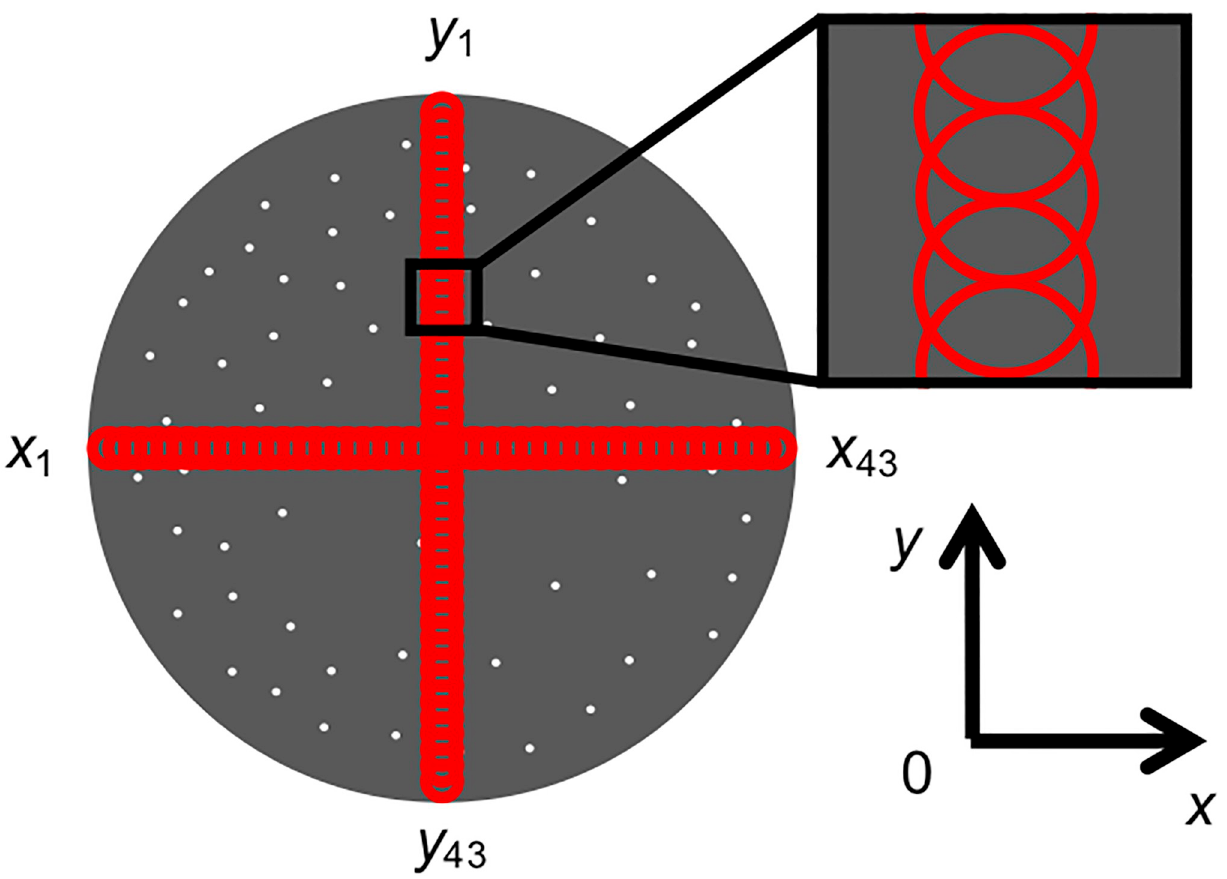
Fig 2. Measurement areas for evaluation of cell